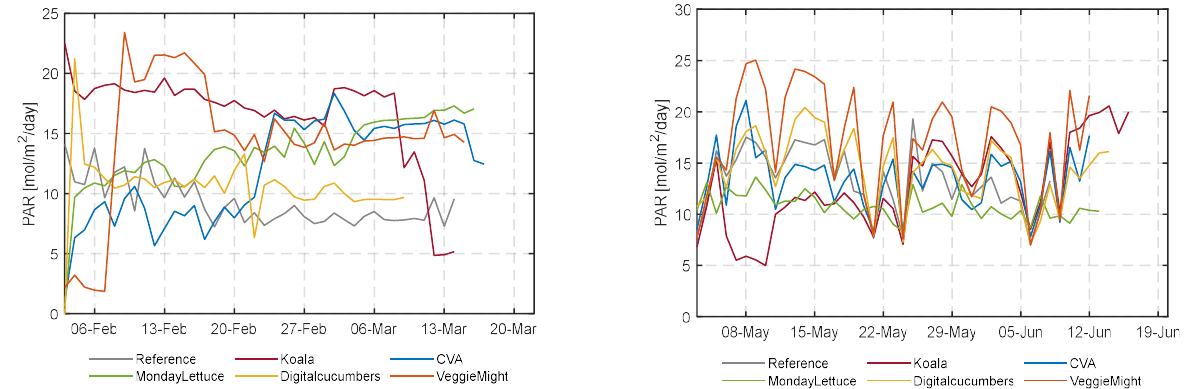
Figure 9. Indoor photosynthetic active radiation (PAR) for the different compartments during the first and second cultivation.